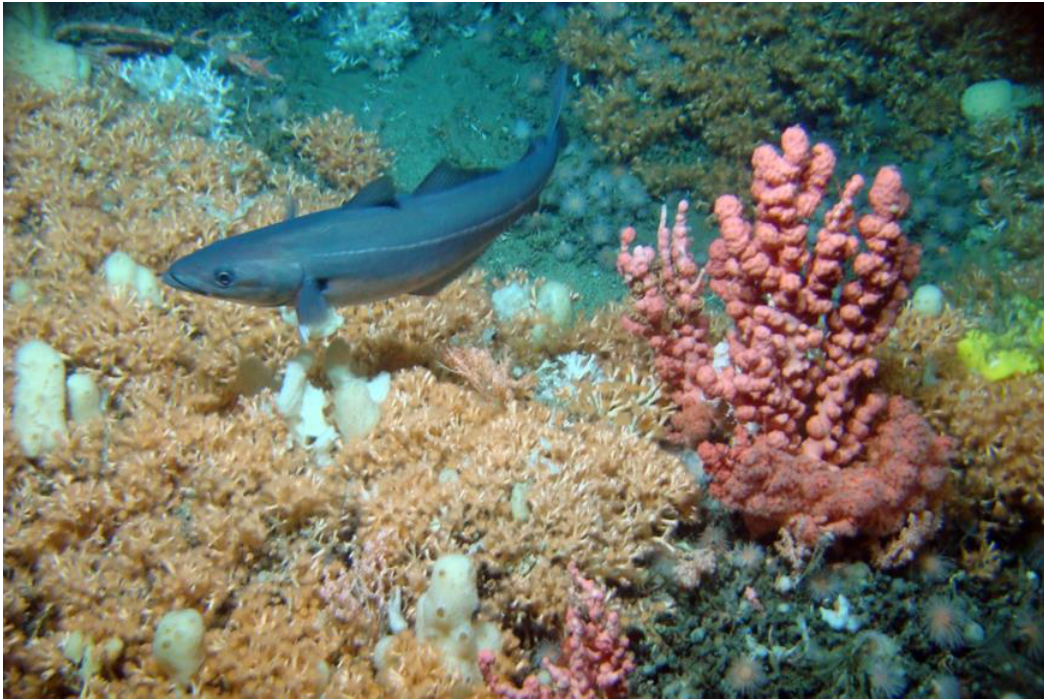
Figure 6. Coral reef with visible polyps. Their activity patterns in opening and closing inform about feeding dynamics. Further, activity patterns are also associated with human impacts (e.g., from industrial activities; Photo: S. Flögel).